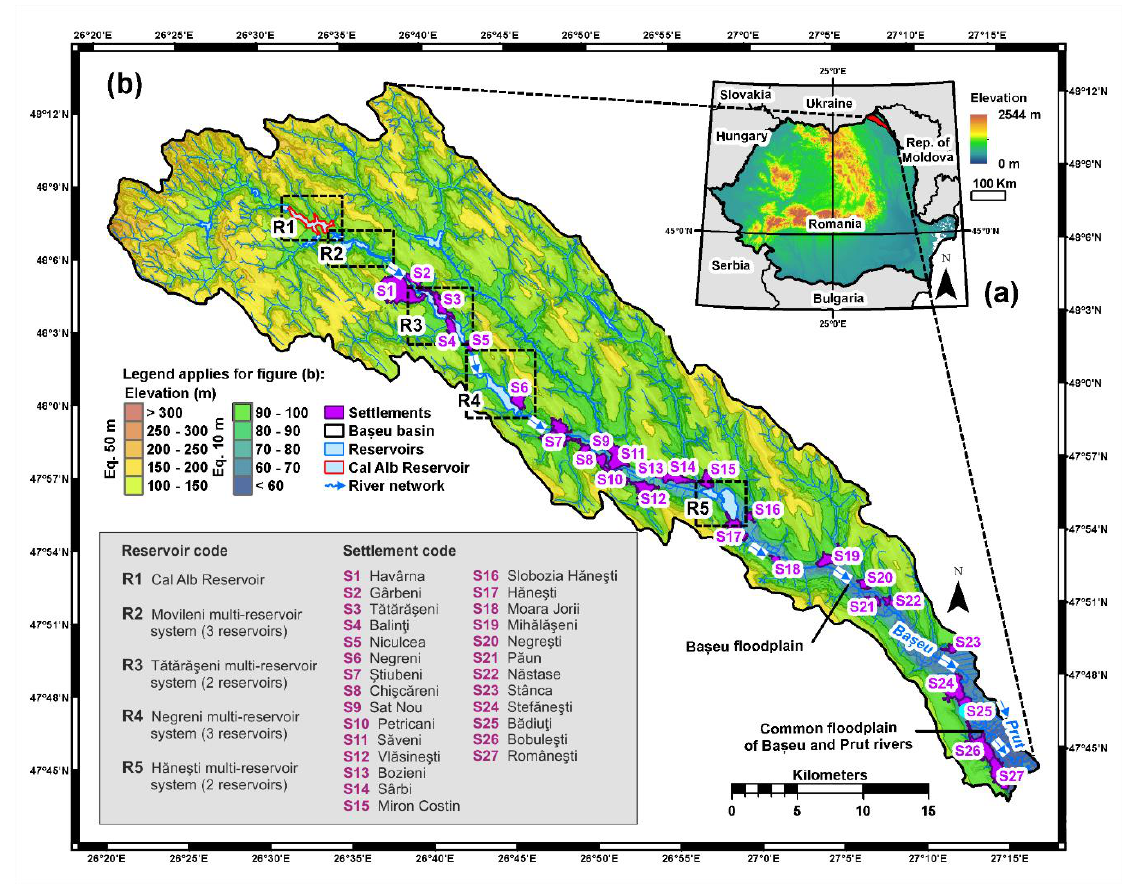
Figure 1. ( a ) Geographic location of the study area in northeast (NE) Romania; ( b ) elevation map of the Başeu multi-reservoir system based on light detection and ranging (LiDAR)-derived digital elevation model (DEM) [31]. The abbreviations within the ( b ) map indicate the location of R1–R5 reservoirs and dams built up for protection of S1–S27 settlements.